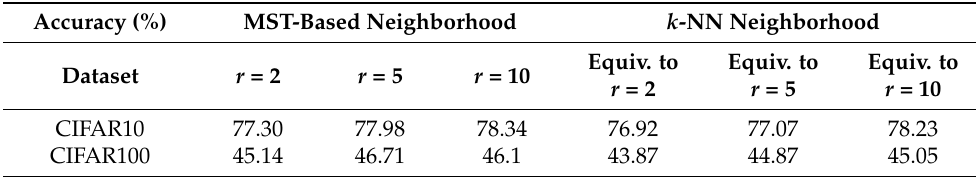
Table 5. Comparison between different neighborhood criteria for geometric regularization with AC loss using the NiN instructor model.